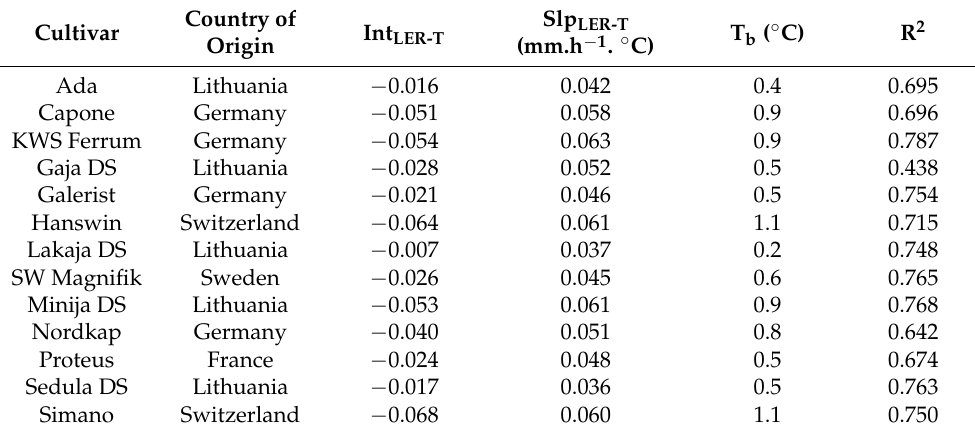
Figure 3. Leaf growth in response to temperature of 13 winter wheat varieties. ( a ) represents genotype-based daily mean leaf elongation rate (LER) data ( n > 4300 per month) of 13 cultivars (in dark- and light-grey signs) as well as temperature (solid red line) plotted against calendar time, and ( b ) shows LER plotted against thermal time. Table 1. Origin of cultivars and mean intercept and slope of the response of leaf elongation rate (LER) to temperature (Int LER-T , Slp LER-T ) as well as derived base temperature (T b ) and coefficient of determination R 2